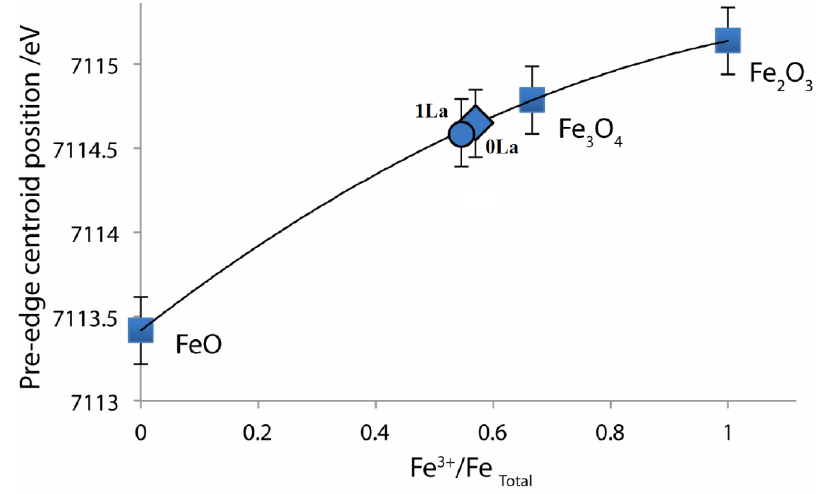
Figure 16. Interpolation of Fe oxidation state in 0La and 1La samples as a combination of Fe 3+ and Fe 2+ , which is predicted to be around +2.57.